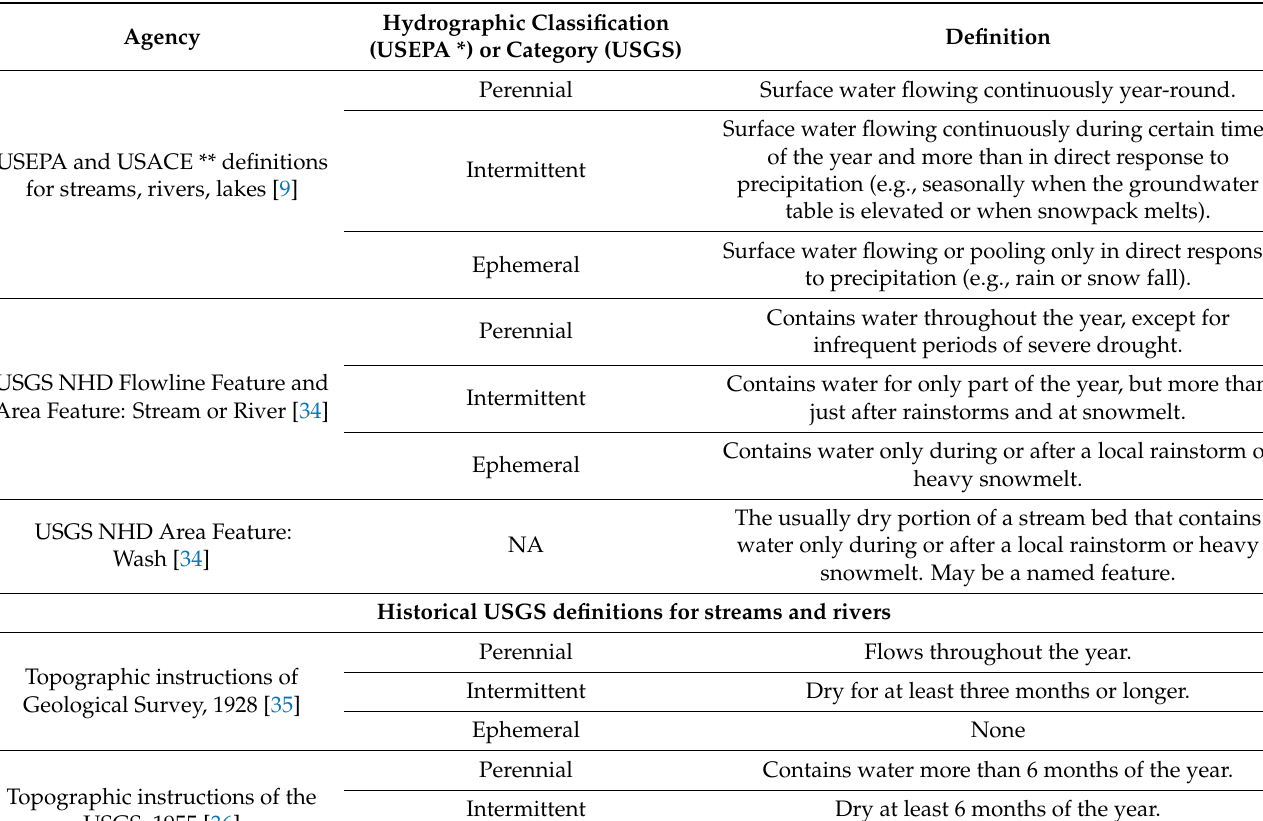
Table 1. Current definitions of hydrographic classifications for Navigable Water Protection Rule compared to current and historical definitions of USGS hydrographic categories for NHD flowlines and area features classified as stream, river, or wash based on patterns of streamflow